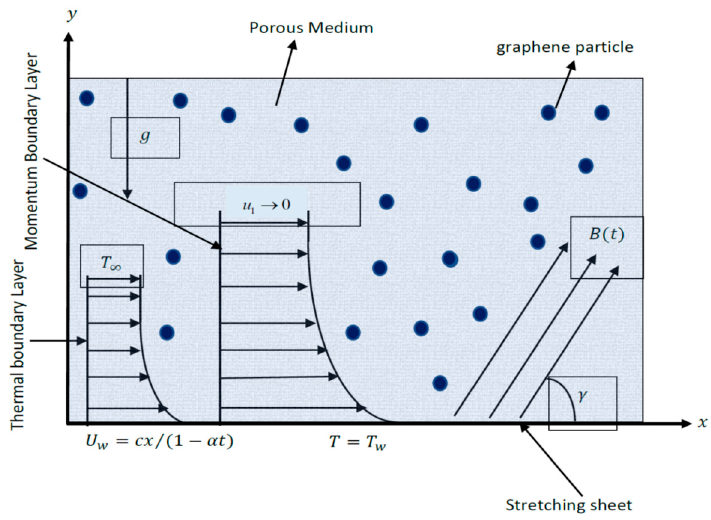
Figure 1. Physical illustration of the problem.